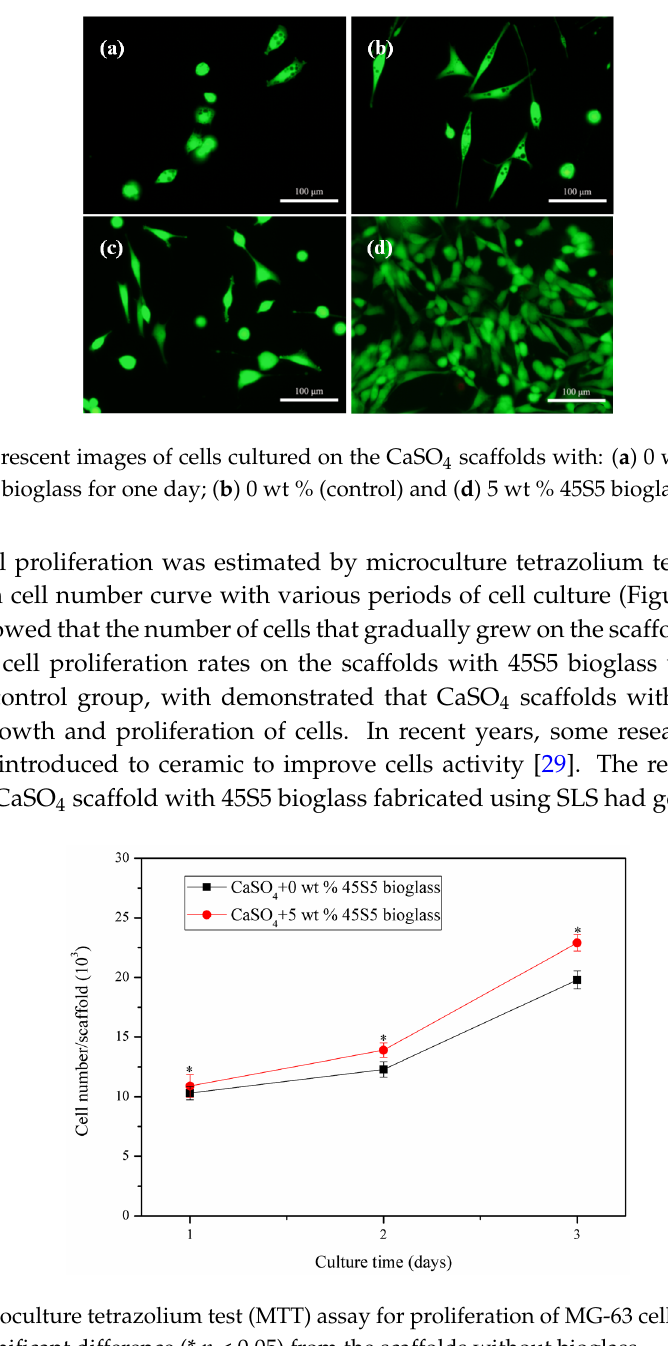
Figure 11. Scanning electron microscopy (SEM) images of cells cultured on the CaSO 4 scaffolds with: ( a ) 0 wt % (control) and ( c ) 5 wt % 45S5 bioglass for one day; ( b ) 0 wt % (control) and ( d ) 5 wt % 45S5 bioglass for three days. I: cells. II: cell ‐ cell junctions.